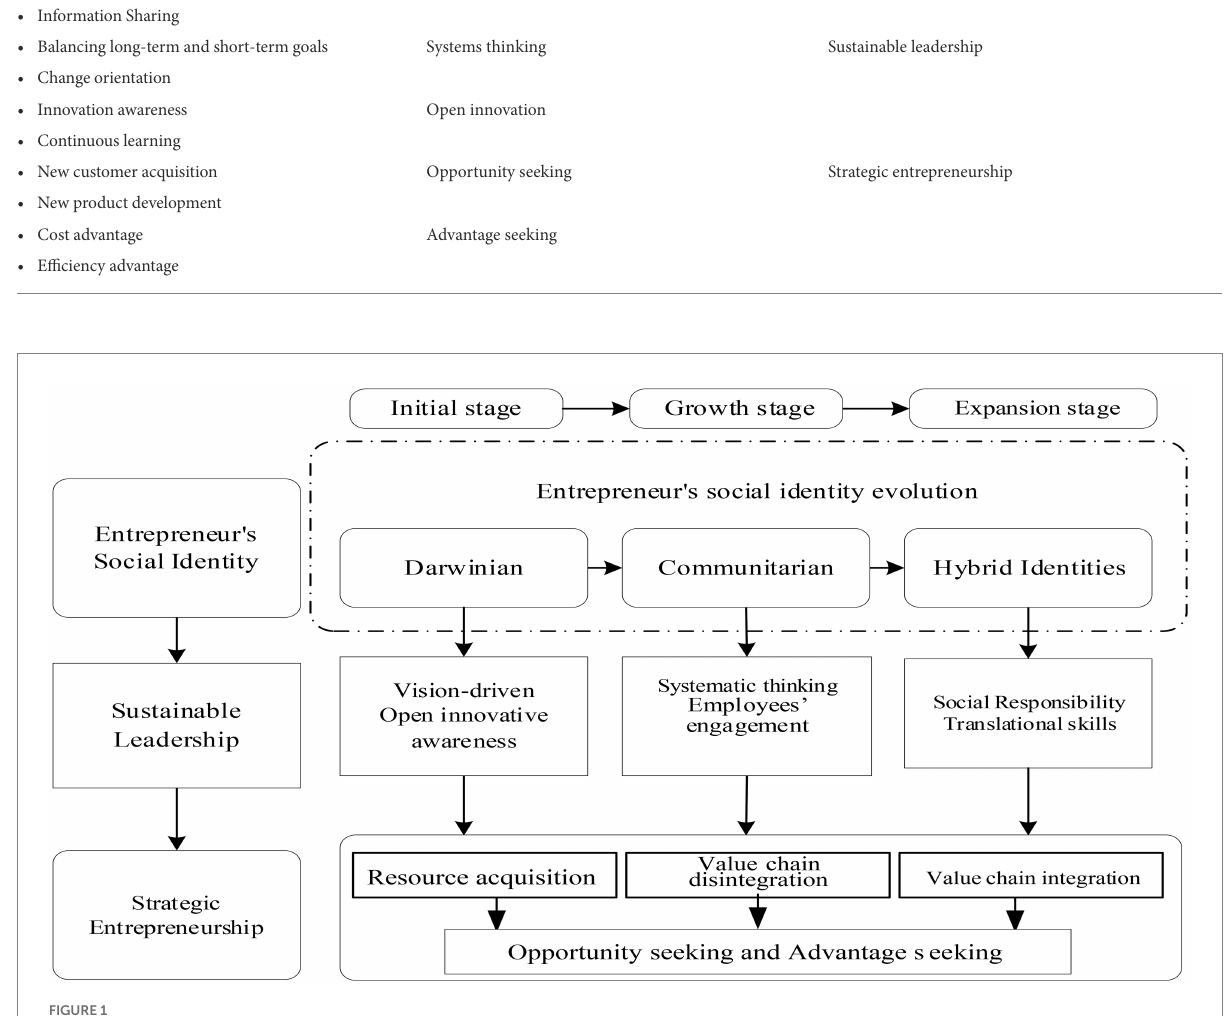
FIGURE 1 Theoretical mode.